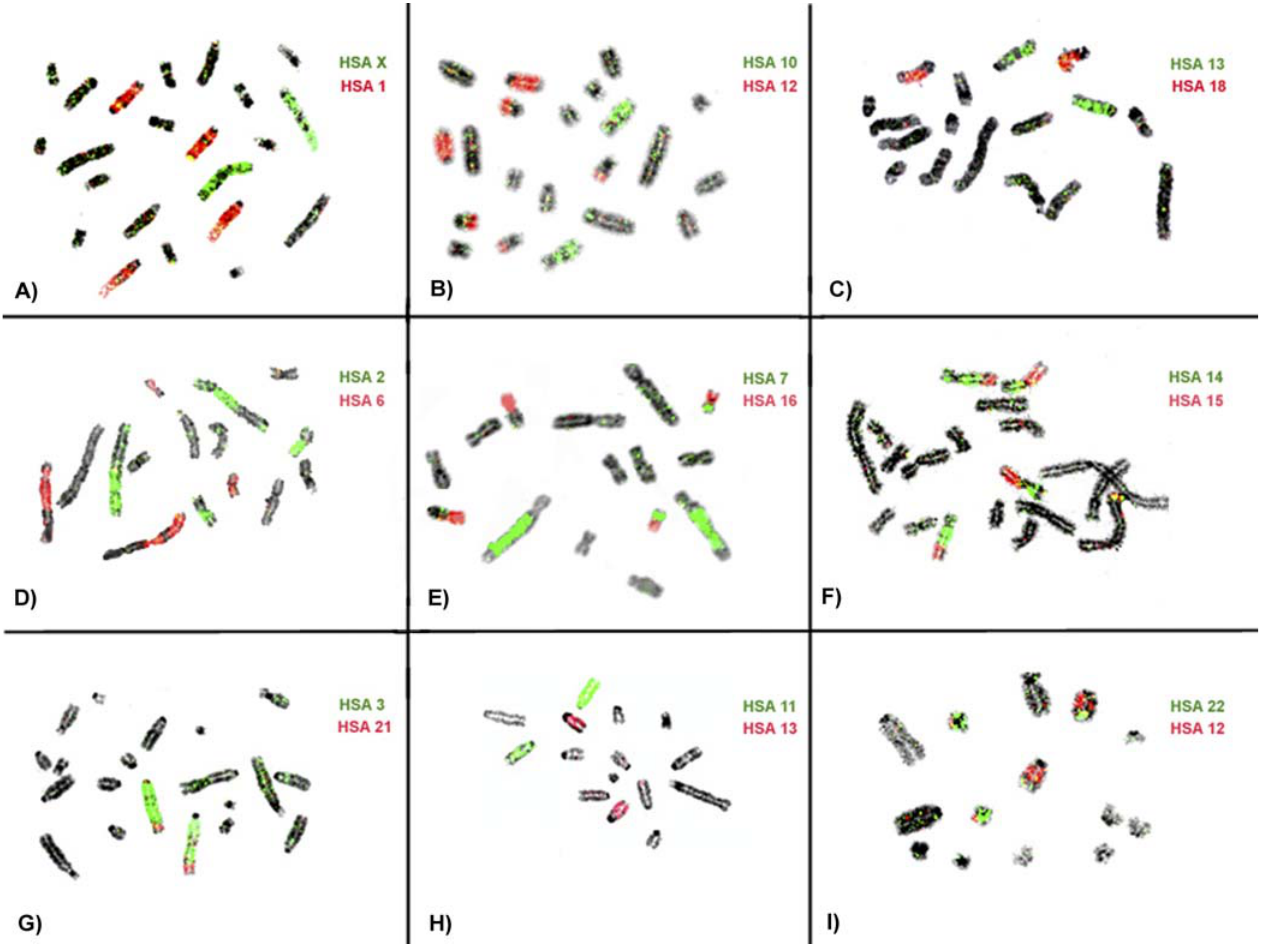
Figure 1. Partial Metaphases of D. novemcinctus, T. tetradactyla, and C. hoffmanii after In Situ Hybridization with Human Chromosome–Specific Probes (A–C) D. novemcinctus, (D–F) T. tetradactyla, and (G–I) C. hoffmanii . Two probes were used in each experiment, and the hybridizations were detected with avidin–FITC (green) and antidigoxigenin–rhodamine (red). The chromosomes were counterstained with DAPI, and the human chromosome probes used are indicated. DOI: 10.1371/journal.pgen.0020109.g001